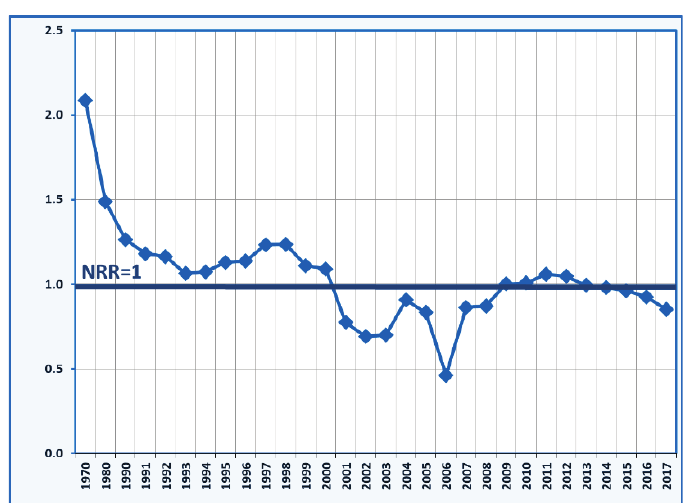
Figure 13. Net reproduction rate of the population of Azerbaijan. Source: based on SSC